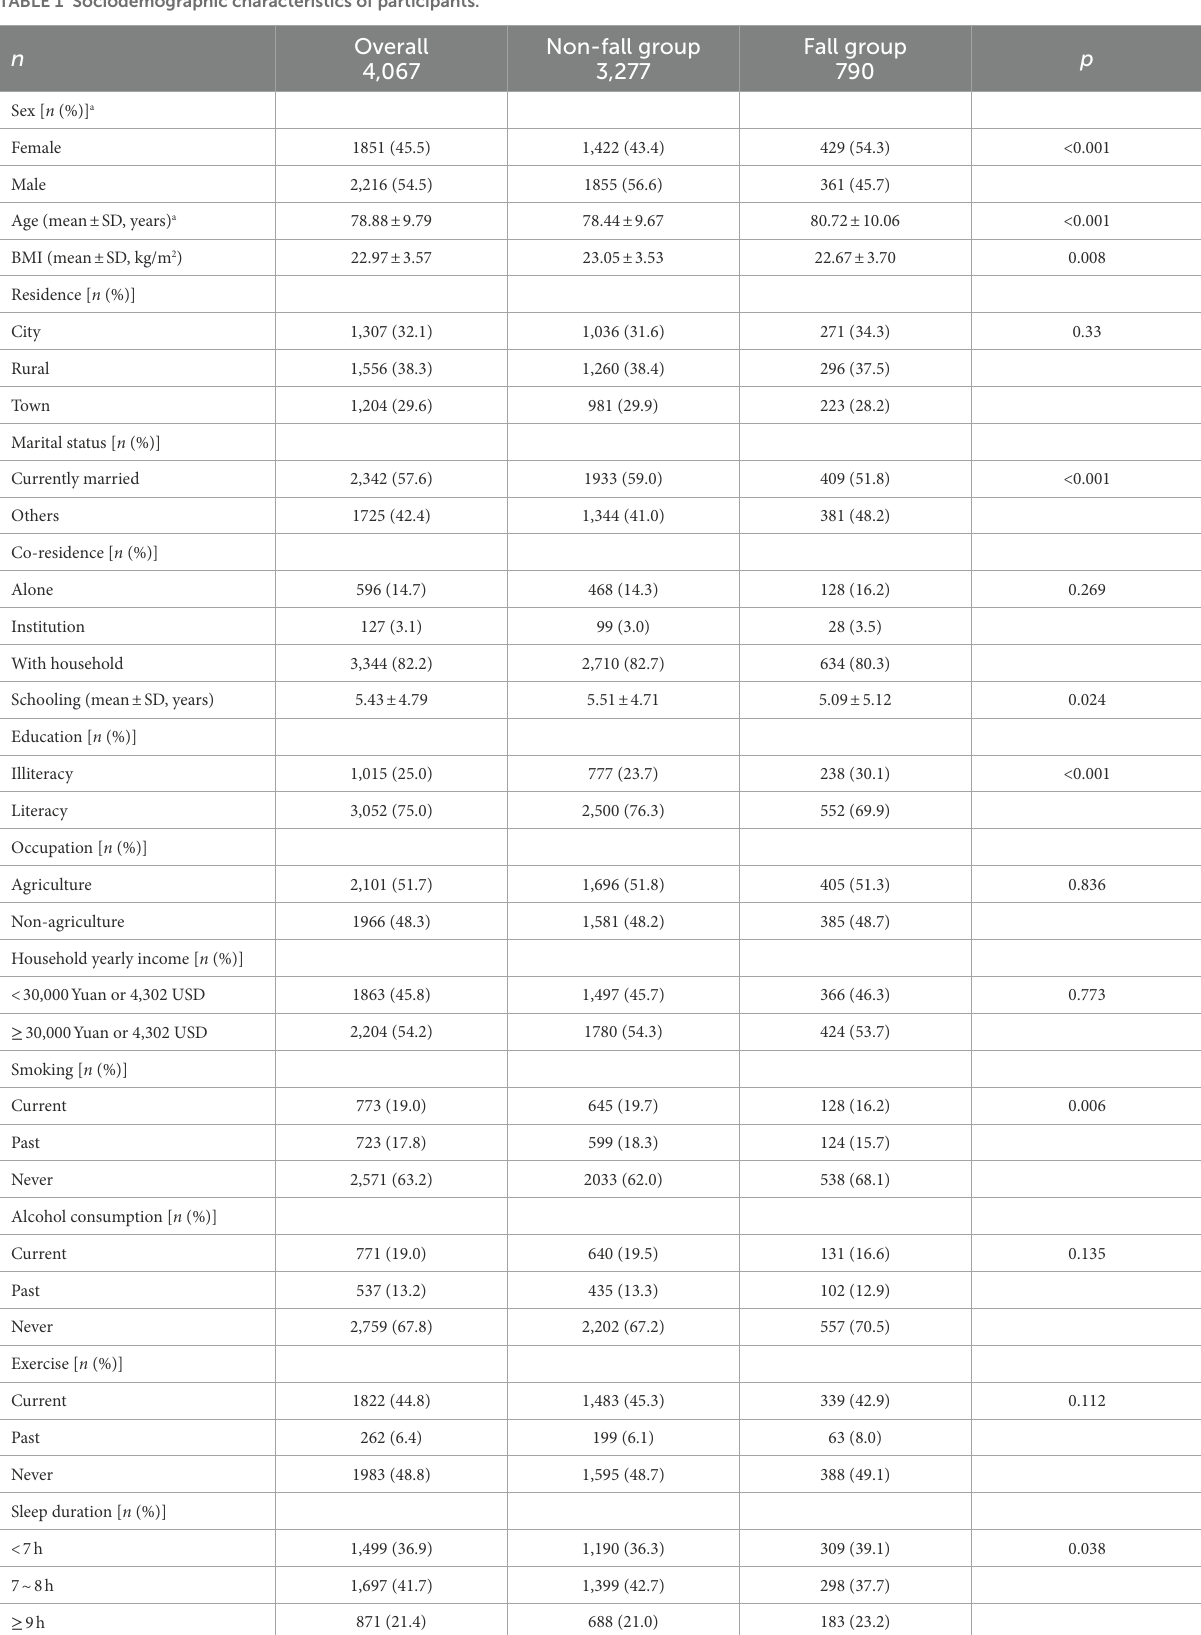
TABLE 1 Sociodemographic characteristics of